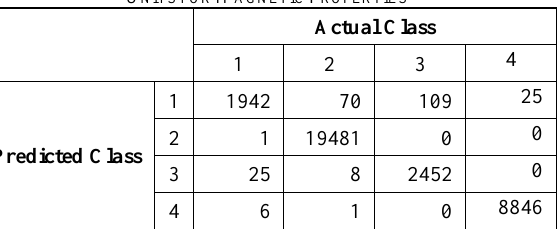
TABLE II U NITS FOR M AGNETIC P ROPERTIES